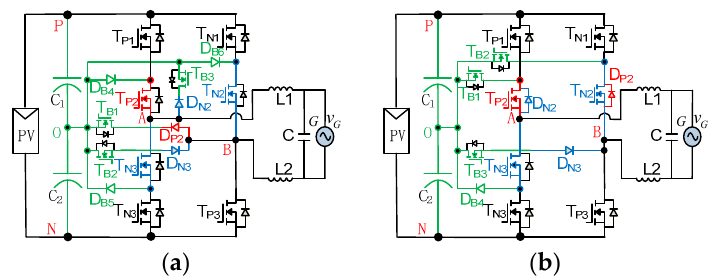
Figure 19. Direct Connection NPC topologies from M = 3, N = 3. ( a ) R9S2 (new); ( b ) R10S2 (new).